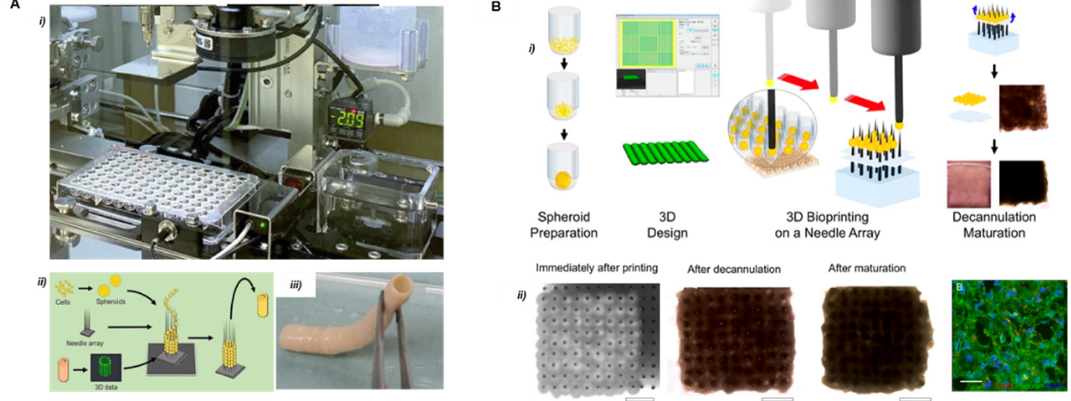
Figure 7. Principles of the Kenzan method. ( A ) Main components of the Kenzan bioprinting automated platform Reprinted with permission from Ref. [40]. Copyrihgt 2021, Springer Nature .(i) Robotic sys- tem. (ii) Illustration of methodology to create a scaffold-free cell-based vascular graft. (iii) A ready to implant cell-based vascular graft (diameter 5 mm × length 5 cm). ( B ) Bioprinting of cardiac patches using microneedle array principle Reprrinted from Ref. [43] (i) Schematic overview of biomaterial- free cardiac bioprinting process. (ii) Optical microscopy images at different steps and confocal mi- croscopy of resulting cardiac patches. Scale bars 40 μ m and 20 μ m, respectively.